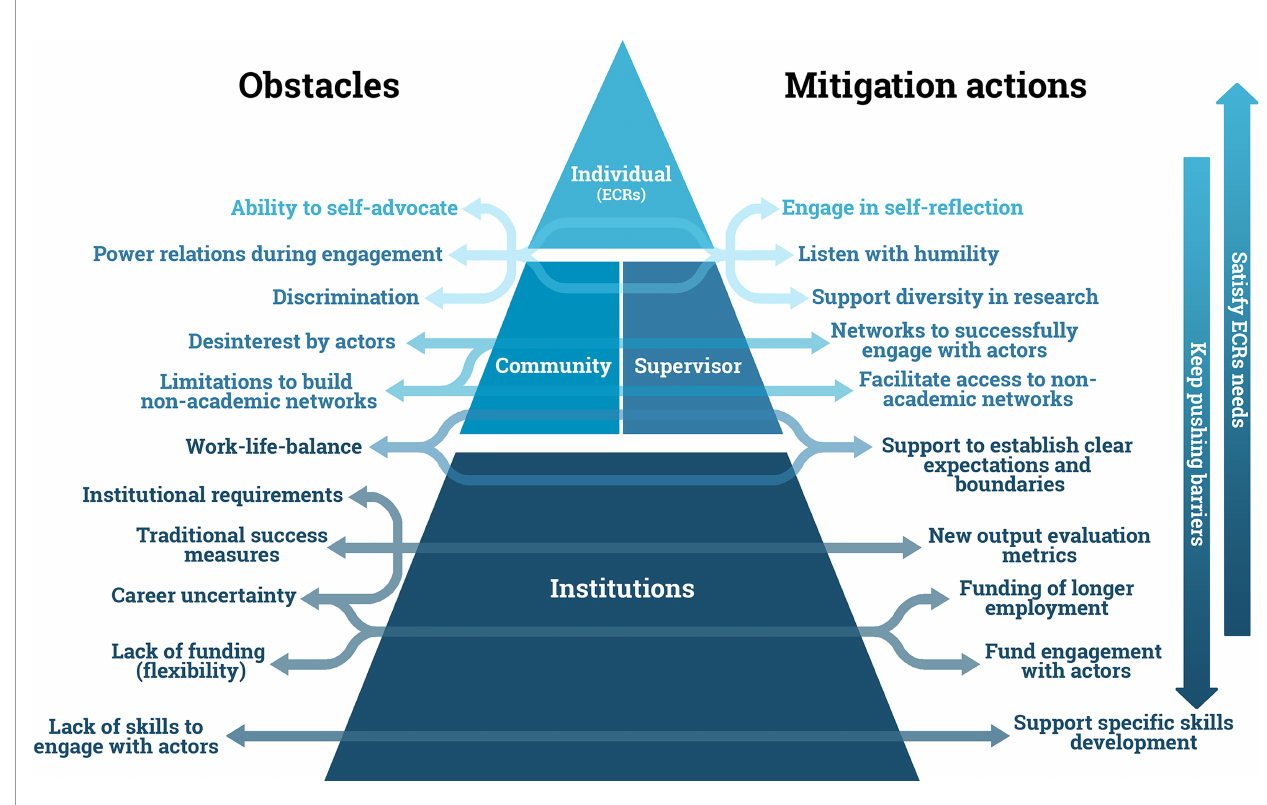
FIGURE 1 | Summary of obstacles (left) to be tackled at different organizational levels (pyramid) with corresponding mitigating actions (right) and action pathways (horizontal arrows). The pyramid represents the hierarchy of needs with institutions (bottom) that are to be met before the needs at the individual level (top) can be resolved. The community (peer and broad scienti fi c community) and supervisory level (middle) were considered as support systems to overcome obstacles and improve the engagement with local actors. Vertical arrows on the right side represent top-down and bottom-up actions that are needed to leverage change towards a more inclusive environment for ECRs engaging in knowledge